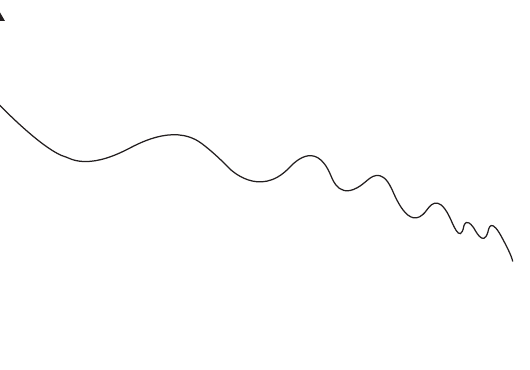
Figure 3: Reverse bubble morphology.